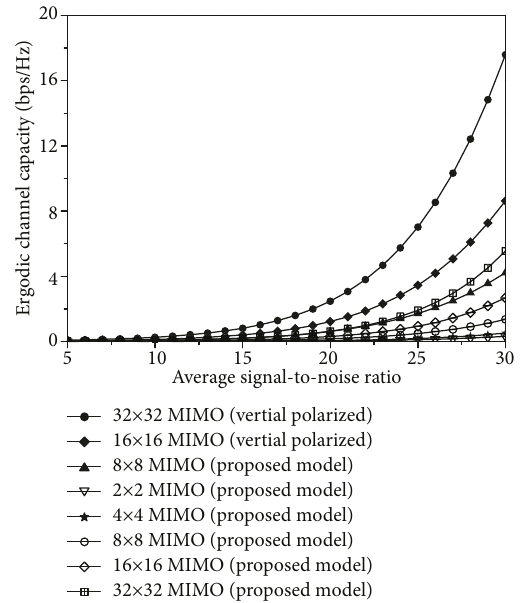
Figure 20: The ergodic channel capacity for the LOS condition. Figure 21: The ergodic channel capacity for the NLOS